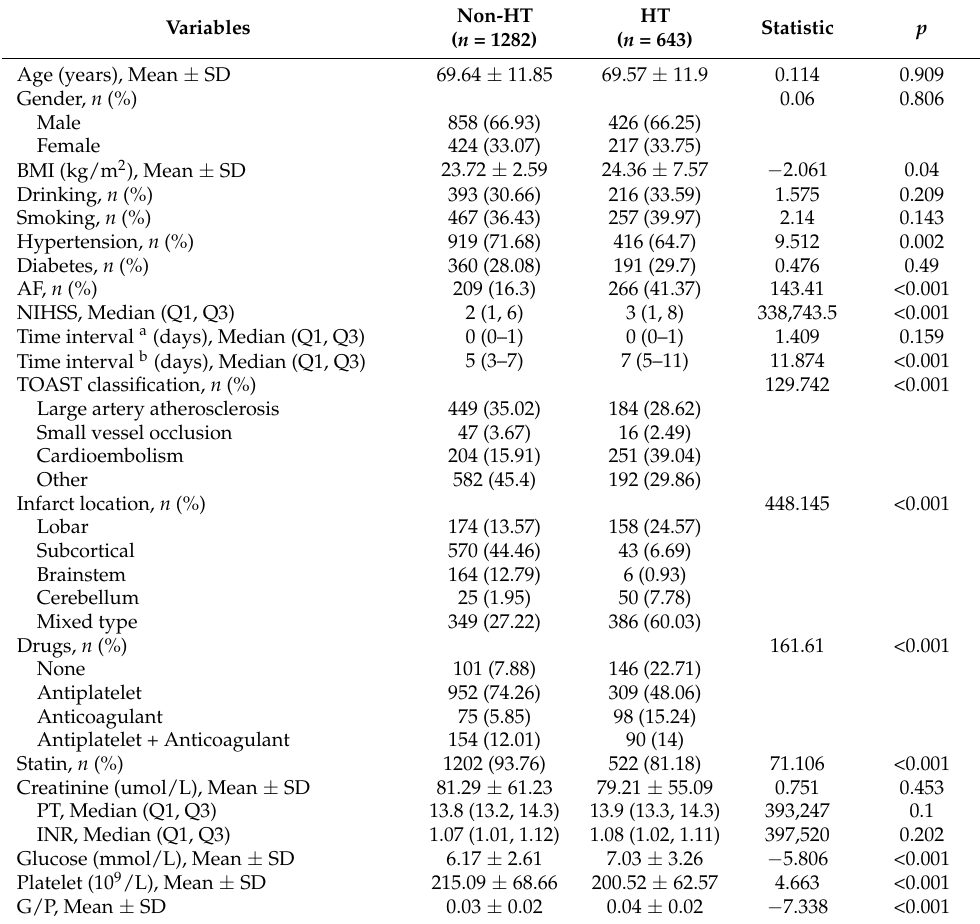
Table 1. Characteristics of AIS patients with or without